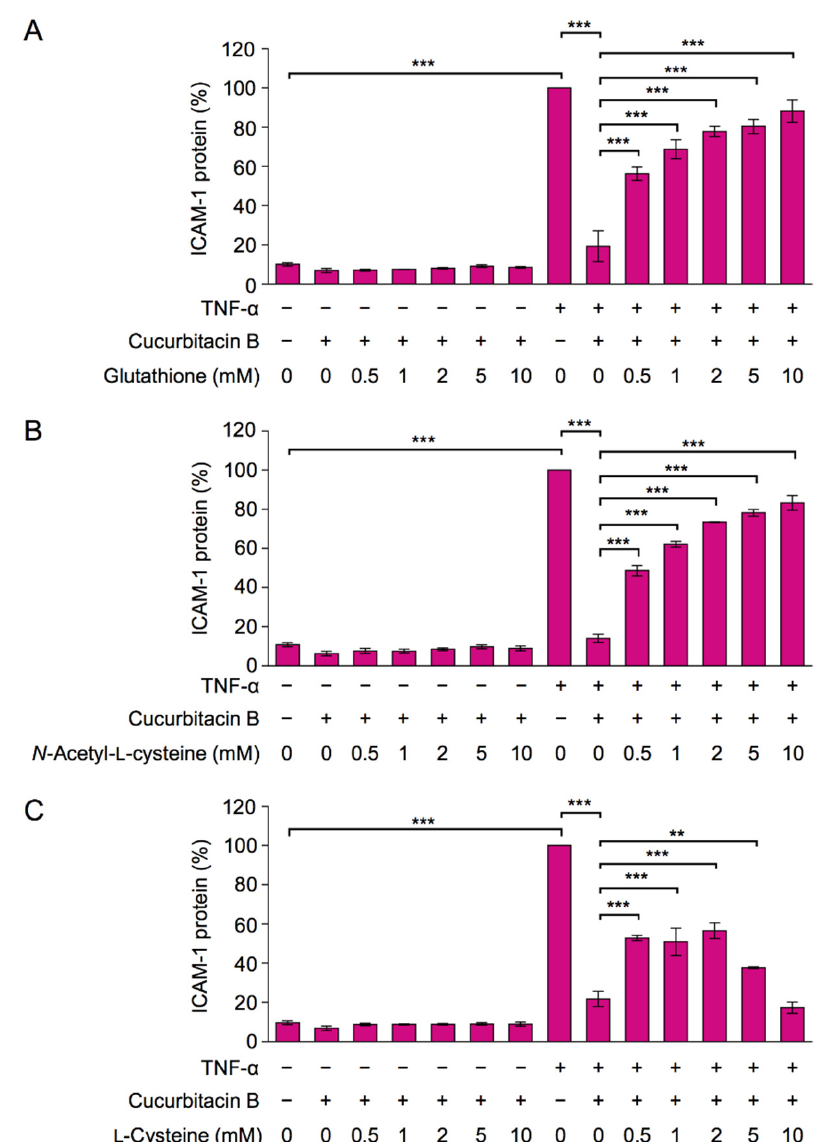
2.5. An α , β -Unsaturated Carbonyl Moiety Was Necessary for the Inhibitory Effect of Cucurbitacin B Cucurbitacin B possesses an α , β -unsaturated carbonyl moiety (Figure 1A), which carbonyl moiety is essential for the inhibitory effects of cucurbitacin B, A549 cells were pretreated with thiol compounds and then with cucurbitacin B, followed by a TNF- α stimulation to induce ICAM-1 expression. Glutathione and N -acetyl-L-cysteine efficiently attenuated the inhibitory effects of cucurbitacin B on TNF- α -induced ICAM-1 expression (Figure 8A,B). The inhibitory effects of cucurbitacin B were also reversed, but to a lesser extent, by L-cysteine (Figure 8C).